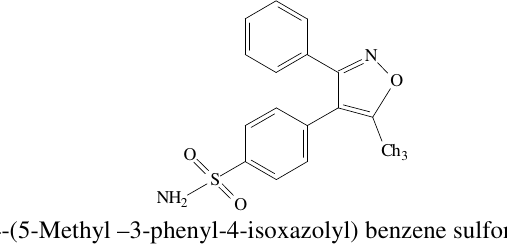
Figure 1. Chemical structure of